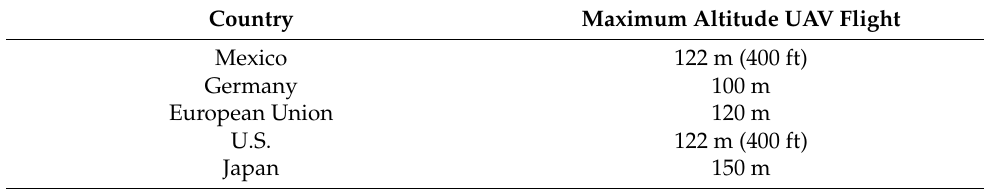
Table 1. Maximum allowed altitude for UAV flights (Prepared by the authors with information from Reger et al.